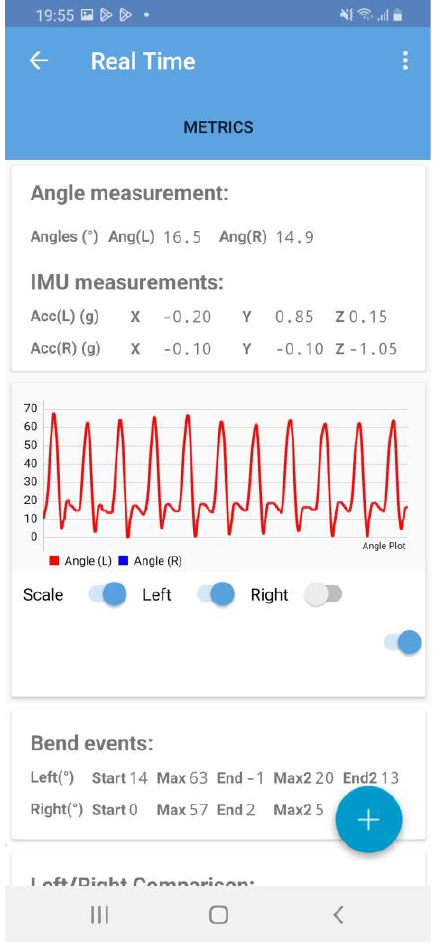
Figure 9. Real-time display of the knee flexion angle on the mobile application.